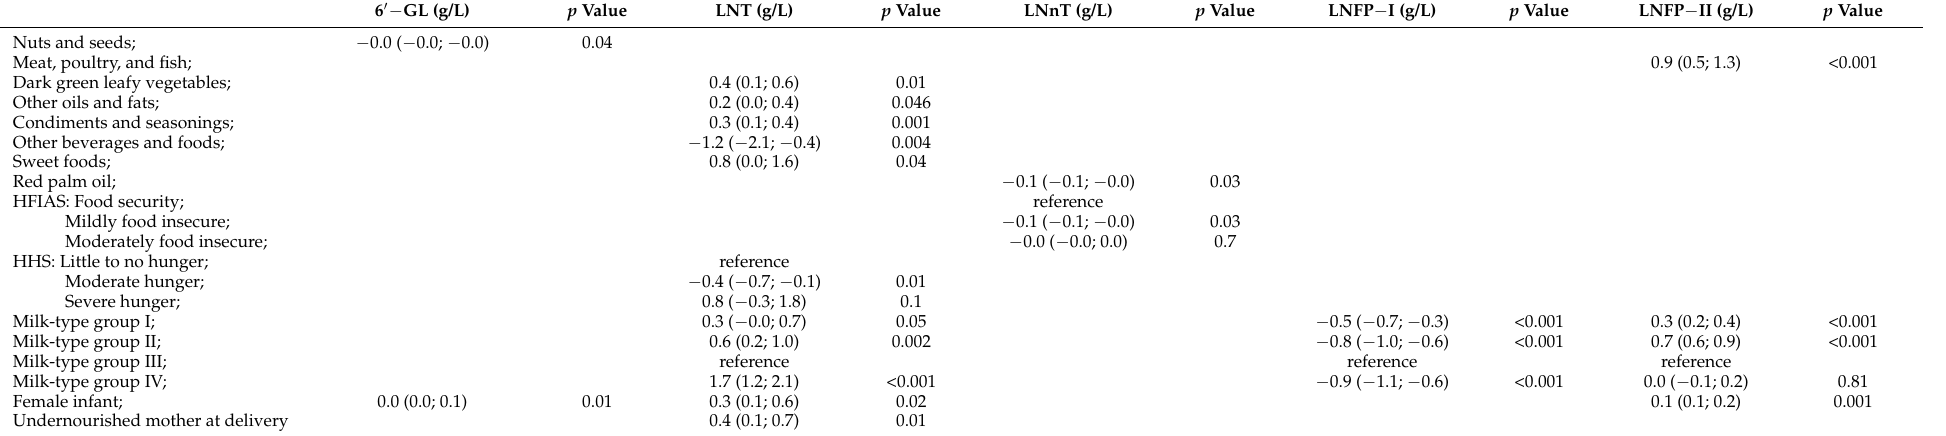
Table 3. Multilevel models of the dietary determinants of human milk oligosaccharide levels during the first 6 months of life